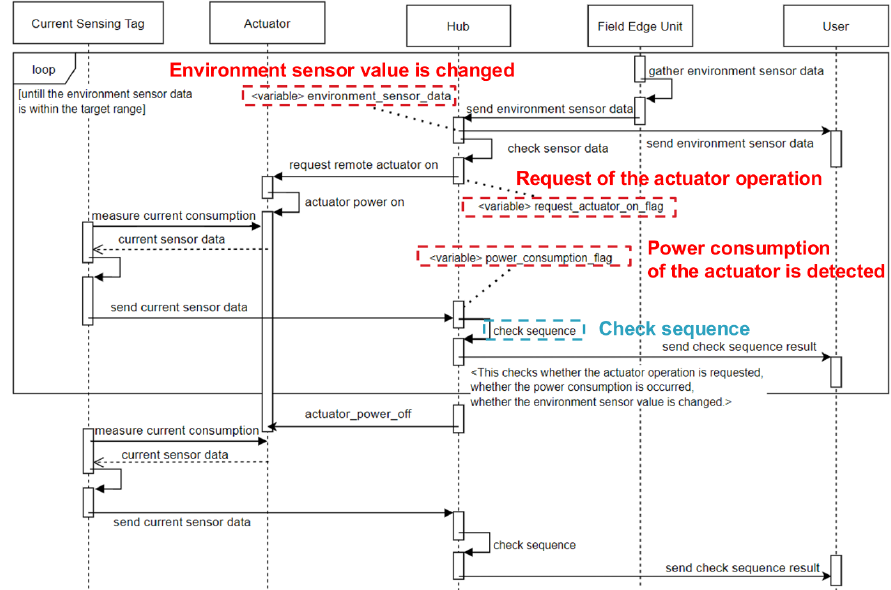
Figure 5. System sequence of proposed. Table 1. Table showing alert